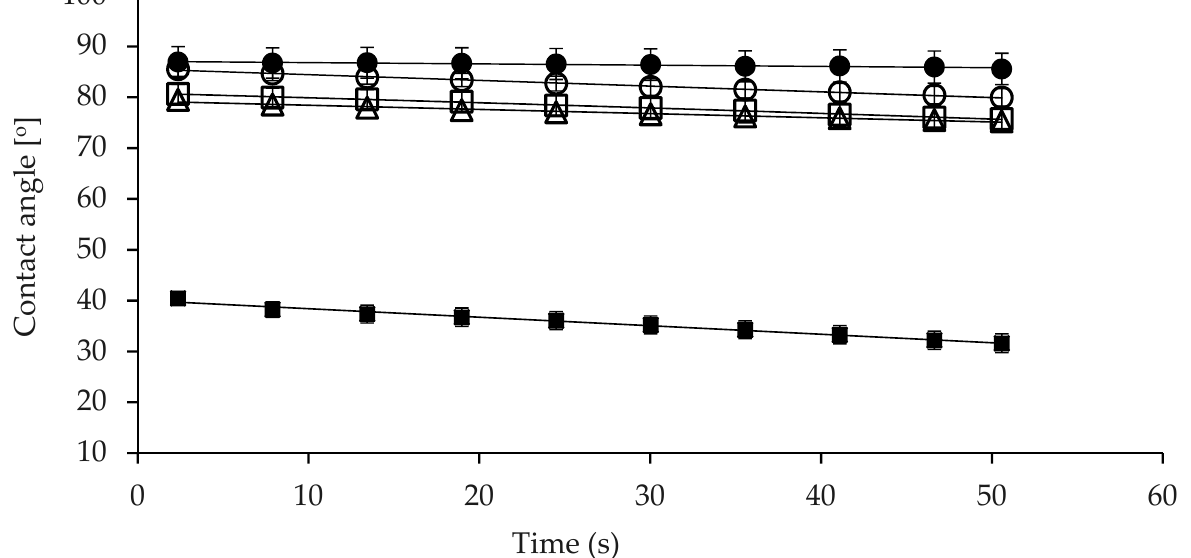
Figure 2. Contact angle values of water droplets on the surface of powder tablets from: ● MCC-SD, spray-dried original powder; ○ P-MCC-0G, freeze-dried MCC powder without GMP addition; □ P-MCC-10G, freeze-dried MCC prepared with 10% GMP as a percentage of total protein; ∆ P-MCC-20G, freeze-dried MCC prepared with 20% GMP as a percentage of total protein; ■ GMP-SD, original spray-dried GMP powder, as a function of time. The error bars represent standard error.